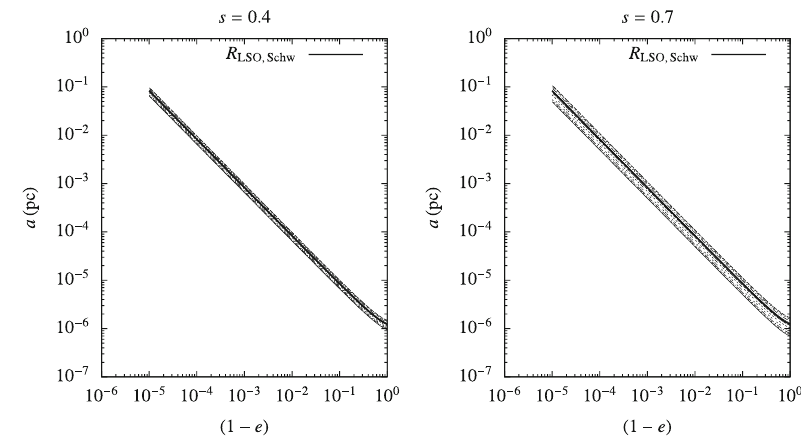
Fig. 57 LSO for a MBH of mass 4 × 10 4 M (cid:2) and a SBH of mass m • = 10 M (cid:2) for a Kerr MBH of spin s = 0 . 4 (left) and s = 0 . 7 (right). The Schwarzschild separatrix is given as a solid black line. Curves above it correspond to retrograde orbits and inclinations of ι = 5 . 72 , 22 . 91 , 40 . 10 , 57 . 29 , 74 . 48 and 89 . 95 ◦ starting from the last value (89 . 95 ◦ ). In the left panel we can barely see any difference from the different inclinations due to the low value of the spin